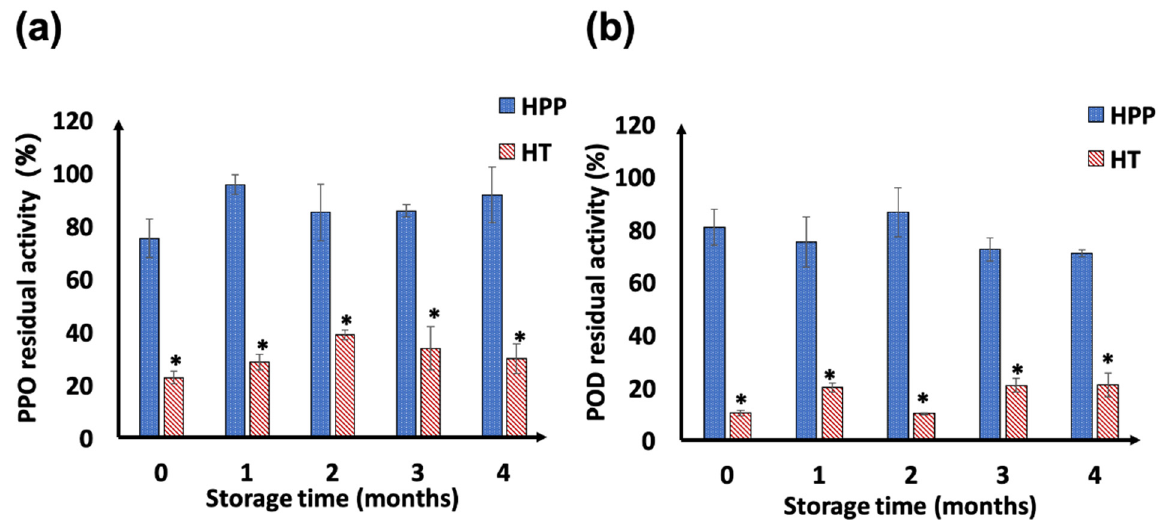
Figure 4. Changes of PPO ( a ) and POD ( b ) residual enzyme activities in HPP- (600 MPa, 3 min) and HT-treated (63 °C, 3 min) purees during 4 months of storage at 4 °C. Denotation of “*” indicates significant difference between different treatments at each sampling point ( p < 0.05).